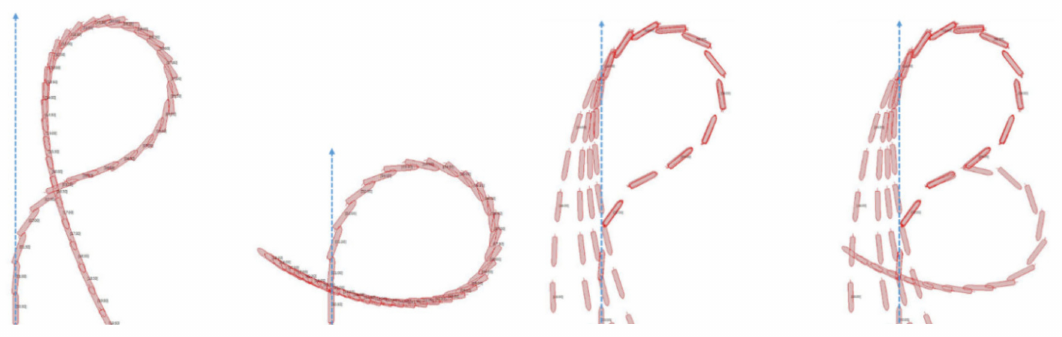
Figure 10. Williamson turn ( far left ), Anderson turn ( 2nd left ) and modified turns ( overlaid ).